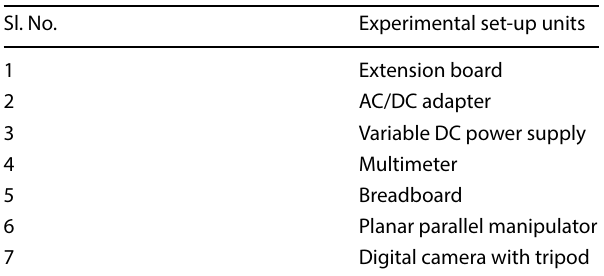
Table 5 Experimental set-up units Sl. No.